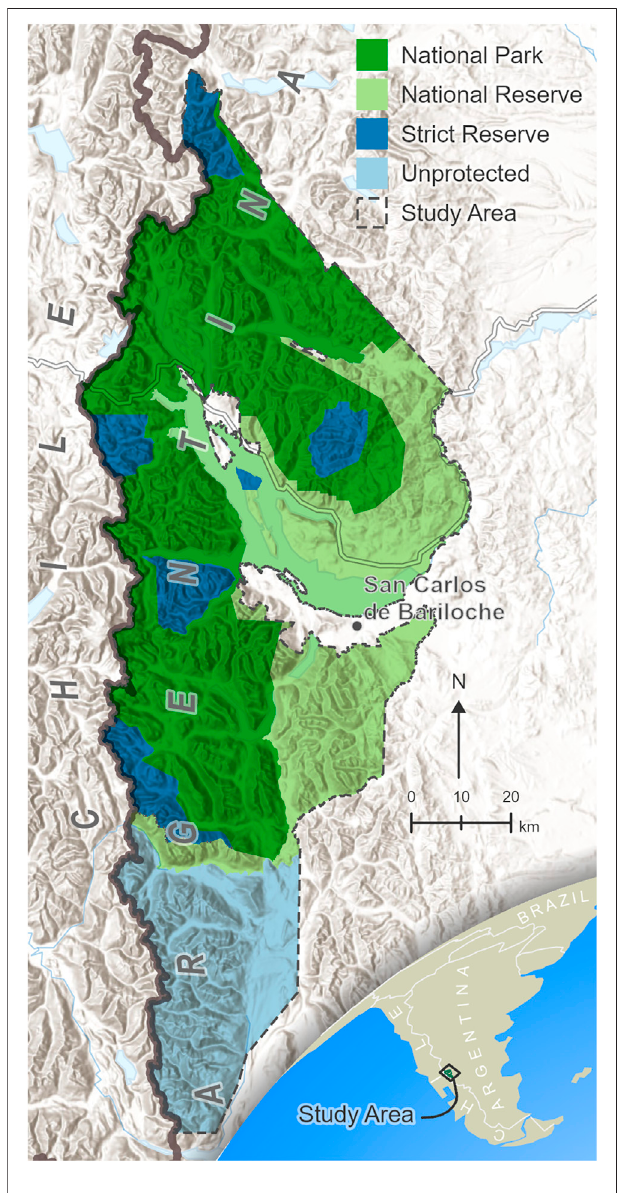
FIGURE 1 | Map of Nahuel Huapi National Park. Levels of protection indicated by different